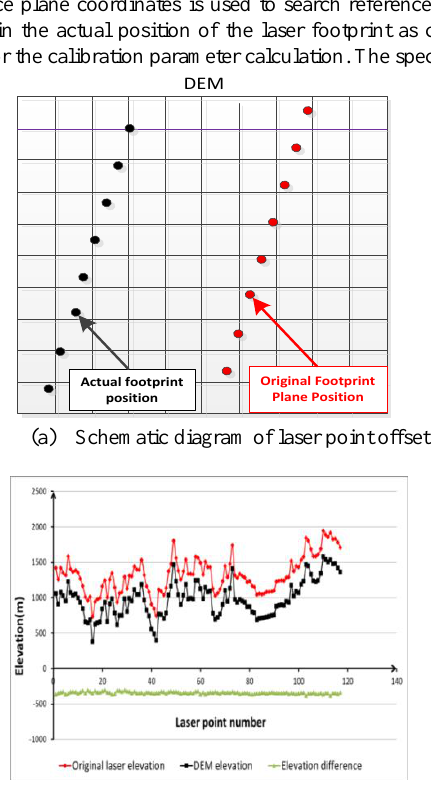
Figure 1. Schematic diagram of laser point offset and elevation curve